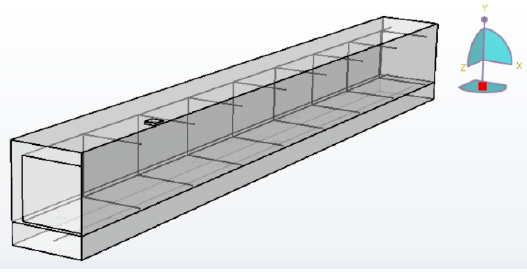
Figure 4. Finite element model of a quarter beam pre-stressed by one Fe-SMA bar in ABAQUS.